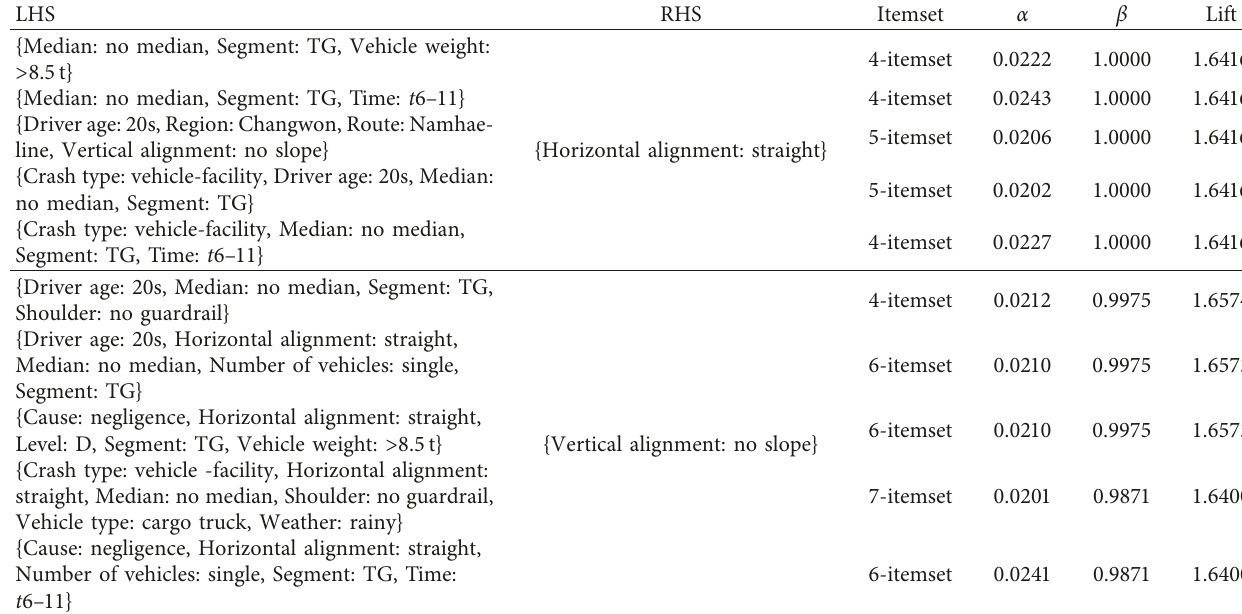
Table 10: Association rules by geometry.